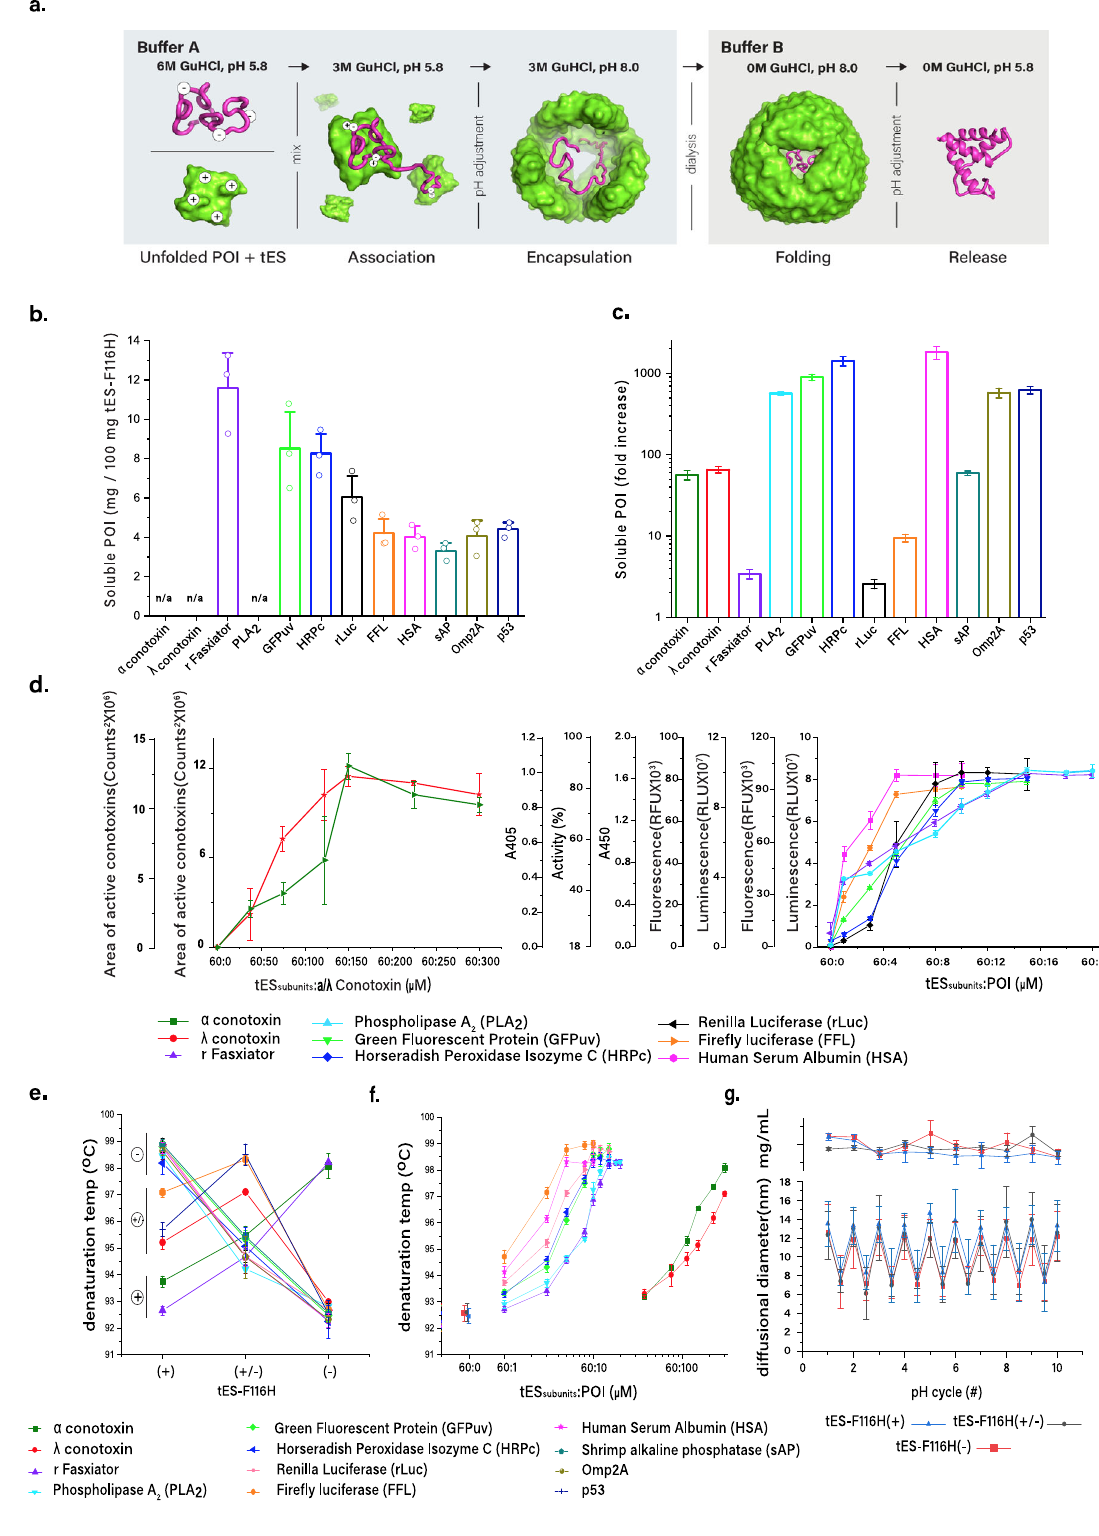
Green fl uorescent protein . Green fl uorescent protein (GFPuv, 27 kDa) is a negatively charged model protein for folding studies and undergoes highly variable expression in E.coli , dependent on induction conditions 26,27 ; thus, GFPuv overexpression in E. coli results in both soluble and insoluble fractions. Correct folding of the native GFPuv structure can be inferred from the development of 508-nm fl uorescence, which requires autocatalytic formation of